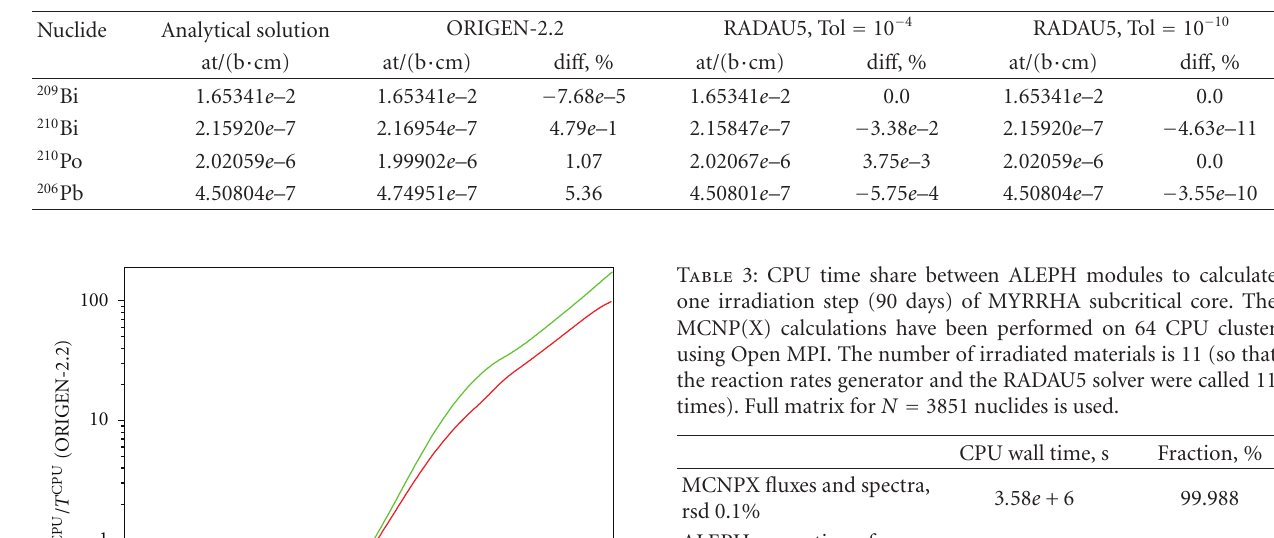
− y anal ) /y anal ) from analytical solution. i i i